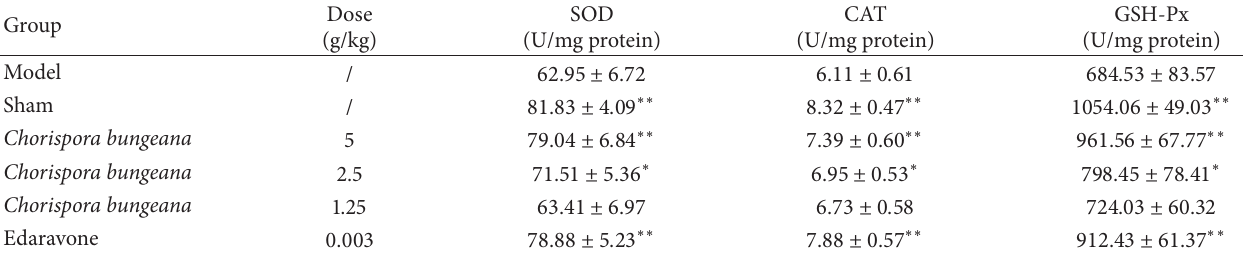
Table 1: Effect of Chorispora bungeana water extract on antioxidant enzyme activities in mice subjected to cerebral ischemia/reperfusion.